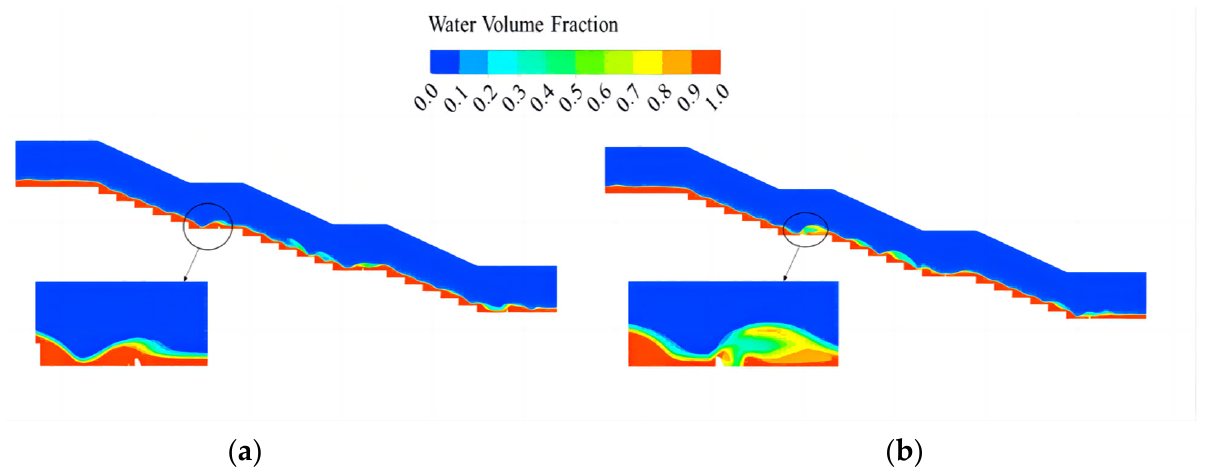
Figure 9. Flow pattern of different longitudinal sections in staggered arrangement. ( a ) Y = 5 cm, and ( b ) y = 7 cm.